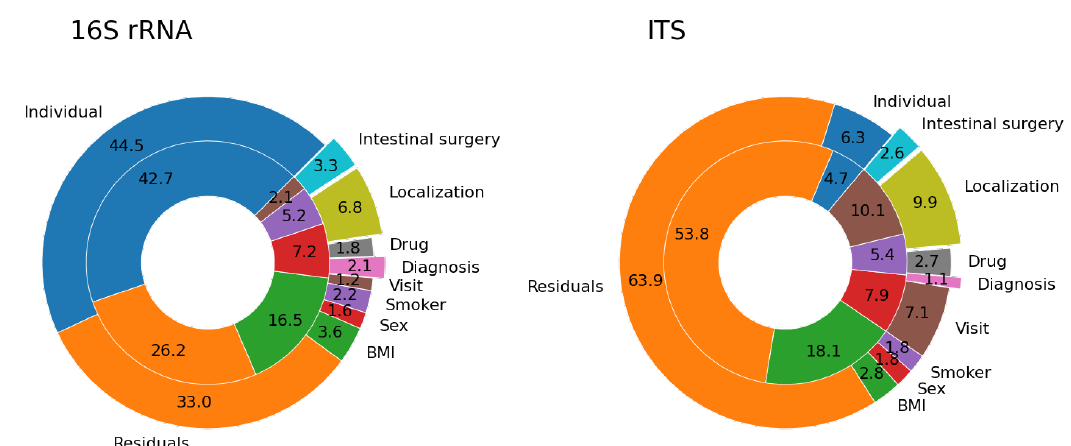
Figure 1. Proportion of beta diversity variance explained by our metadata categories. The pie charts show the percentages of variance in Bray-Curtis dissimilarity explained by different metadata categories in healthy controls (inner ring) and patients with IBD (outer ring). Data for both bacterial (16S rRNA) and fungal (ITS) microbiome are shown. Labels in the outer and inner rings share the same color code.